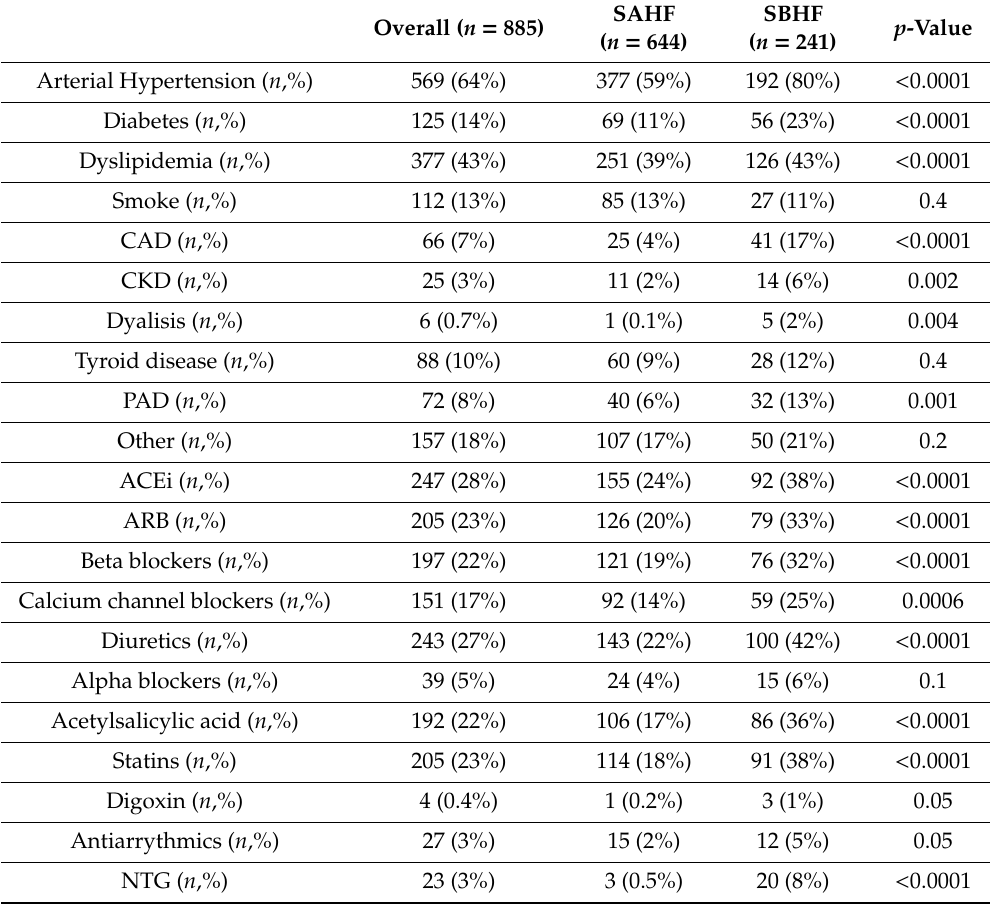
Table A1. Specific clinical characteristics of overall population and according to Heart Failure Stages A and B (SAHF,